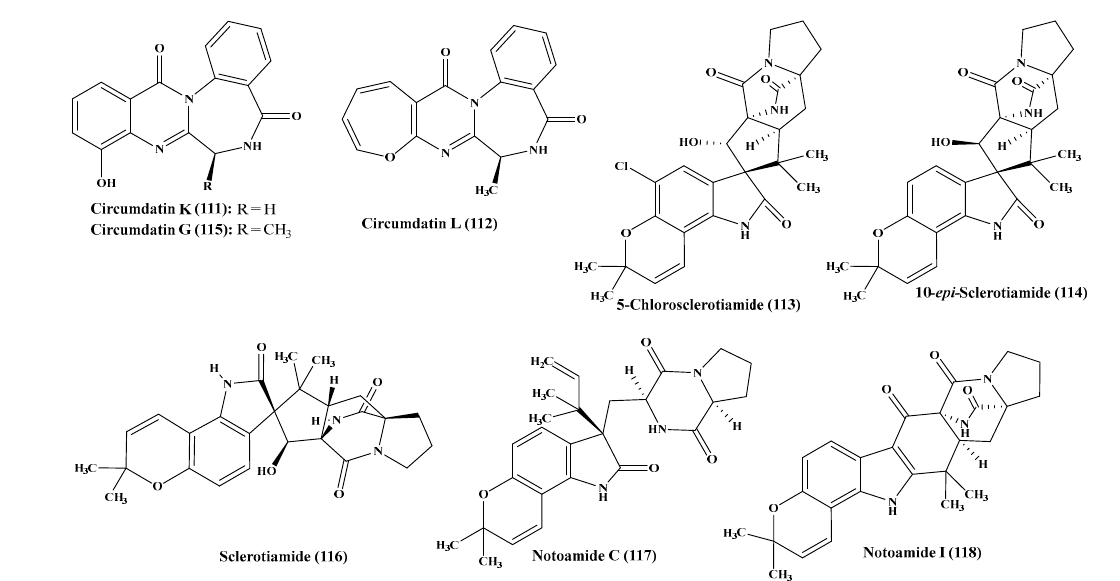
Figure 7. Alkaloids isolated from A. westerdijkiae.